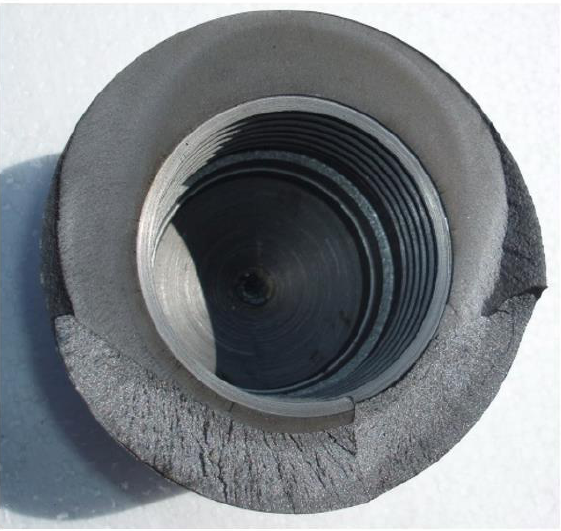
Figure 2. Fracture Figure 2. Fracture surface.